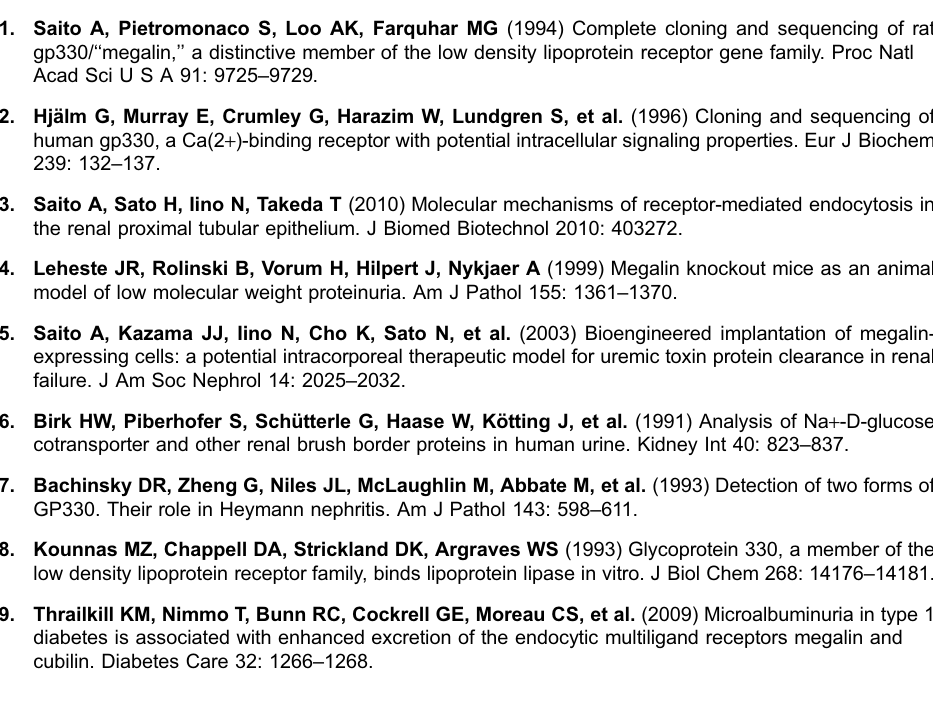
S1 Table. Criteria for selection of normal control individuals among healthy volunteers. S2 Table. Stepwise multiple regression analysis of levels of eGFR with relevant